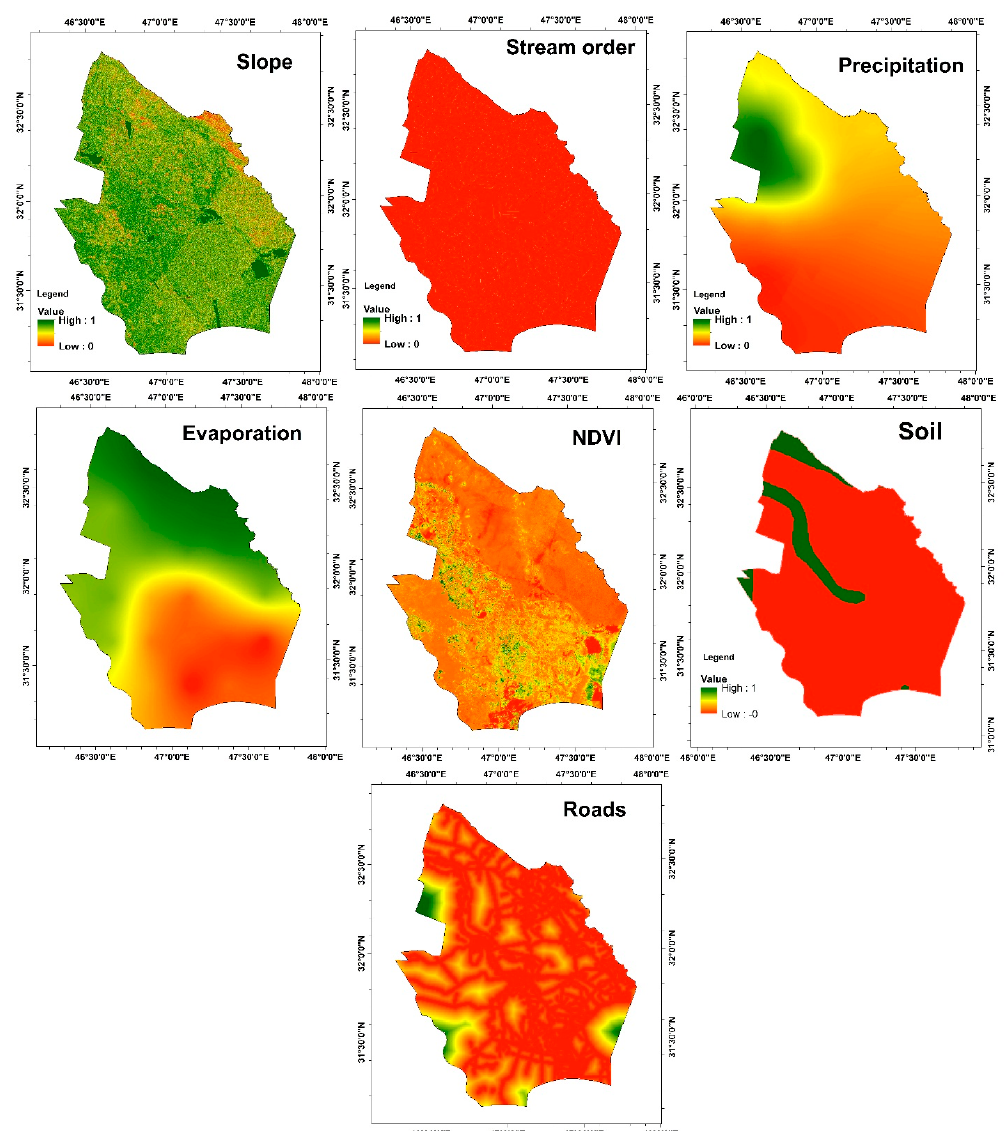
Figure 11. Criteria layers standardization using Fuzzy Linear Membership (FLM).